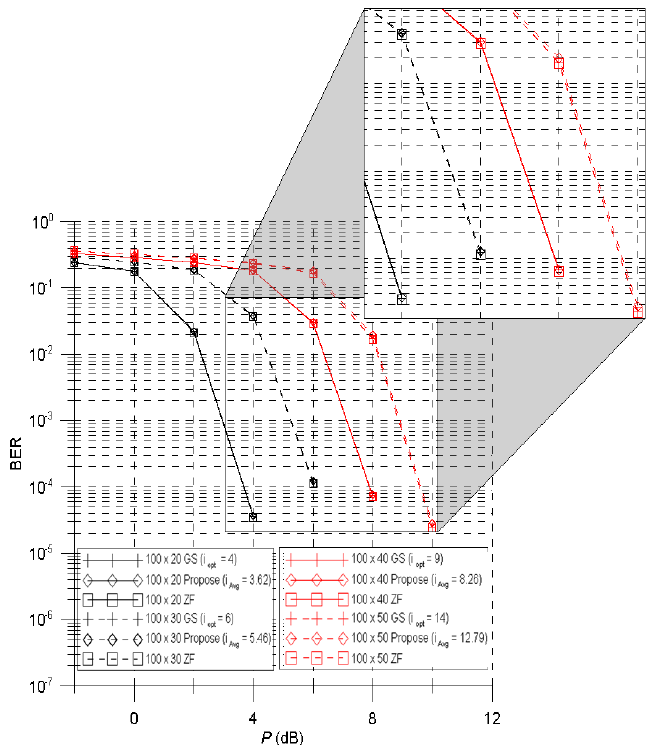
Figure 8. The BER performances for GS pre-coding based on the number of optimal iterations, GS pre-coding based on the proposed estimation scheme, and ZF pre-coding in 100 × 20, 100 × 30, 100 × 40, and 100 × 50 systems when an initial solution is s